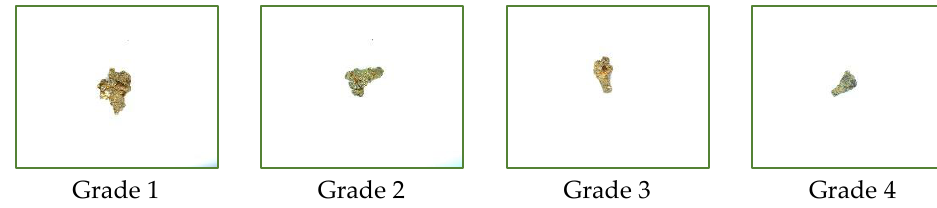
Figure 2. Images of the four grades of Panax notoginseng taproot.